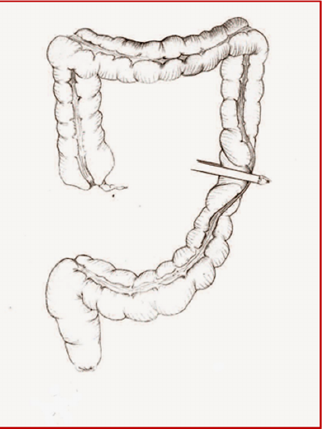
Figure 3. Cologne pouch technique: section of the left colon.